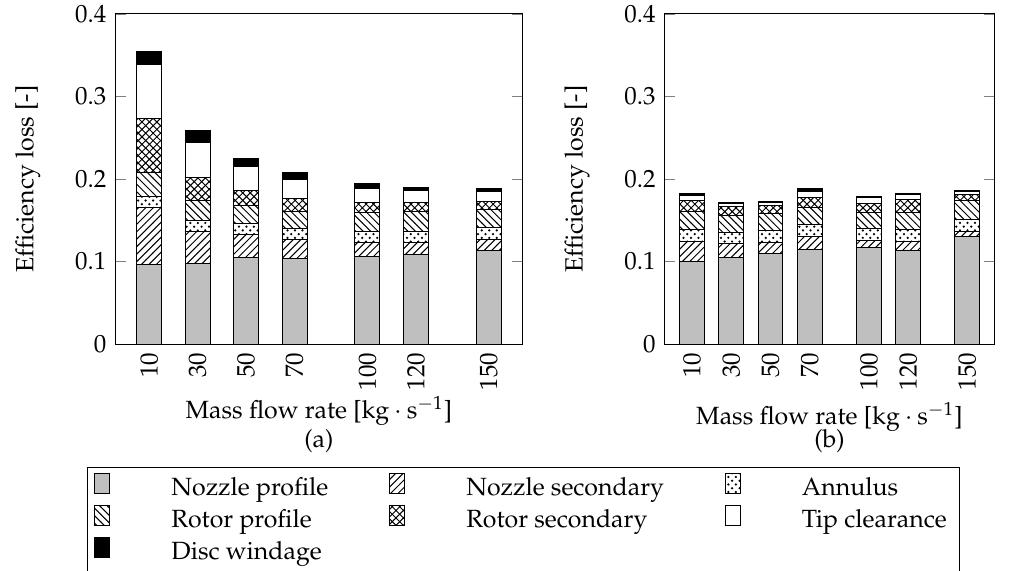
Figure 9. Losses breakdown for the optimal geometries obtained considering: ( a ) constant rotational speed and ( b ) optimized rotational speed. Turbine losses versus mass flow rate for π = 20. The efficiency loss is defined as the complementary fraction for efficiency to reach unity.